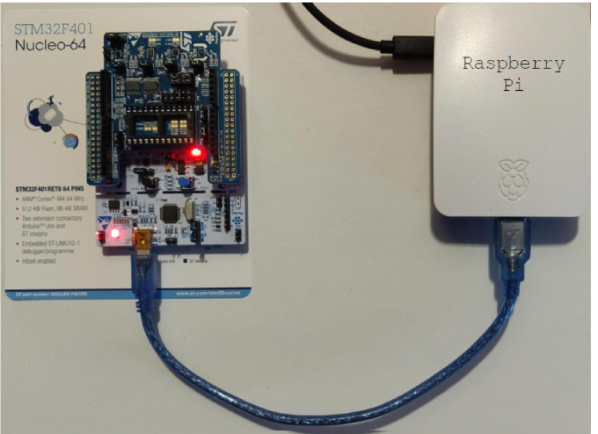
Figure 9. Weather forecast with STM32 microcontroller and Raspberry Pi